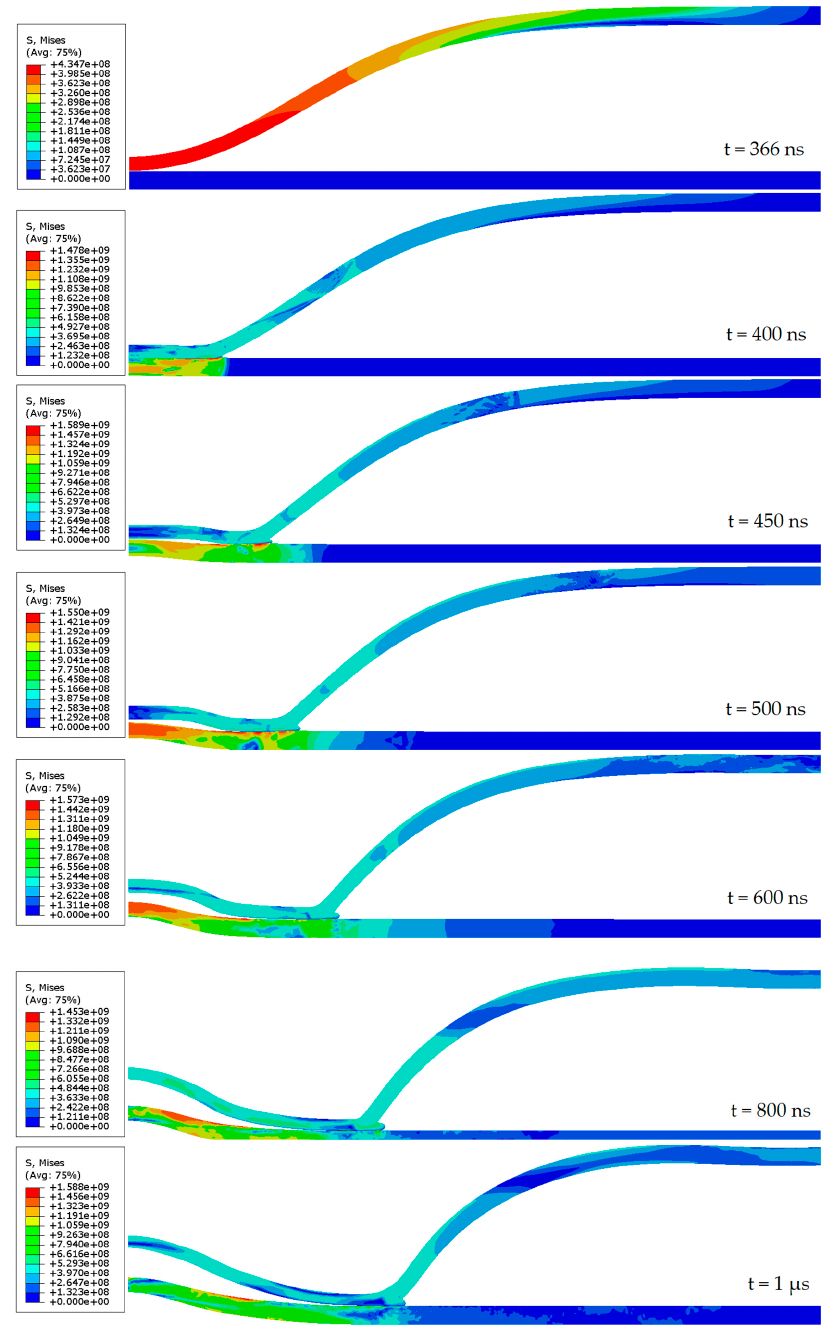
Figure 14. Axisymmetric simulation results: von Mises stress (Pa) contour plot and deformed shape at different times during the collision.